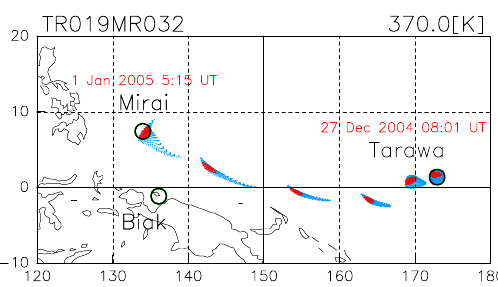
Fig. 1. Example of a cluster of trajectories leaving Tarawa. The blue and red dots are the whole segments calculated from the circled region with a match radius (1 ◦ ) centered at Tarawa. Only the red dots are included in both the first and second circular areas (i.e., those centered at Tarawa and Mirai , respectively); therefore, they represent a match air parcel (see text for details). The footprints are drawn every 24h. The air parcel observed over Tarawa on 27 December 2004 (first observation) was observed again (second ob- servation) over Mirai after about 5